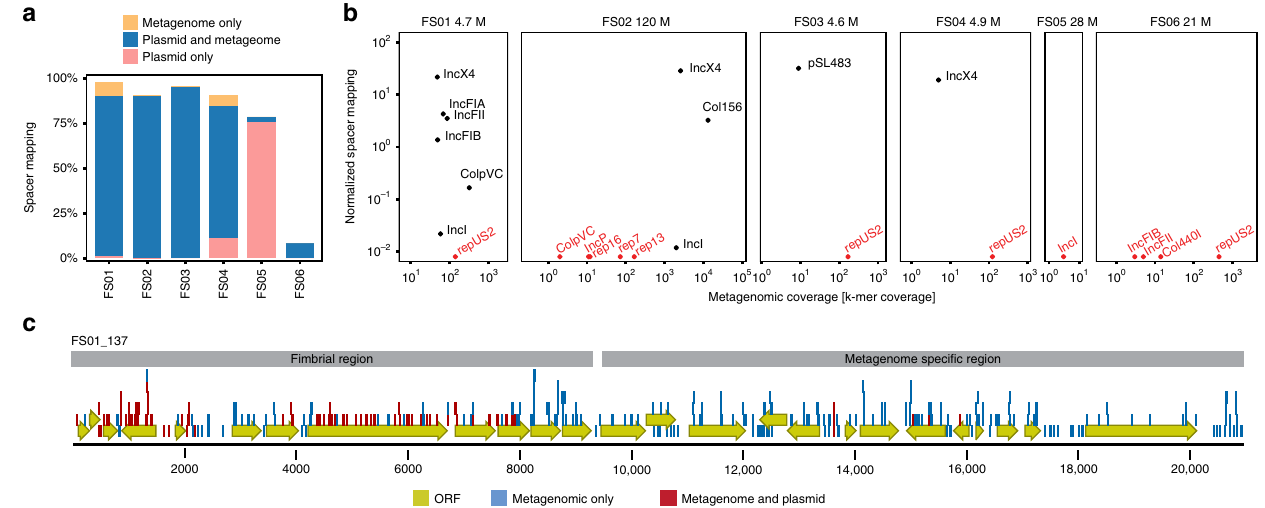
Fig. 6 Metagenomic veri fi cation of predicted transfer events. a Percentage of spacers that could be mapped to the metagenomic contigs only (yellow), plasmid database and metagenomic contigs (blue), or plasmid database only (pink). b Mapping of spacers to predicted metagenomic plasmid contigs as a function of contig coverage in the assembly. The normalized spacer mapping is spacers per kb per 1000 exogenous spacers. Red data points denote zero recorded spacers. Number above each plot denotes the number of reads in the metagenome (millions). c Contig from FS01 where the majority of spacers were speci fi c to the metagenome (blue). The contig consists of a region encoding a P-type fi mbria and a region containing most hypothetical proteins speci fi c to the